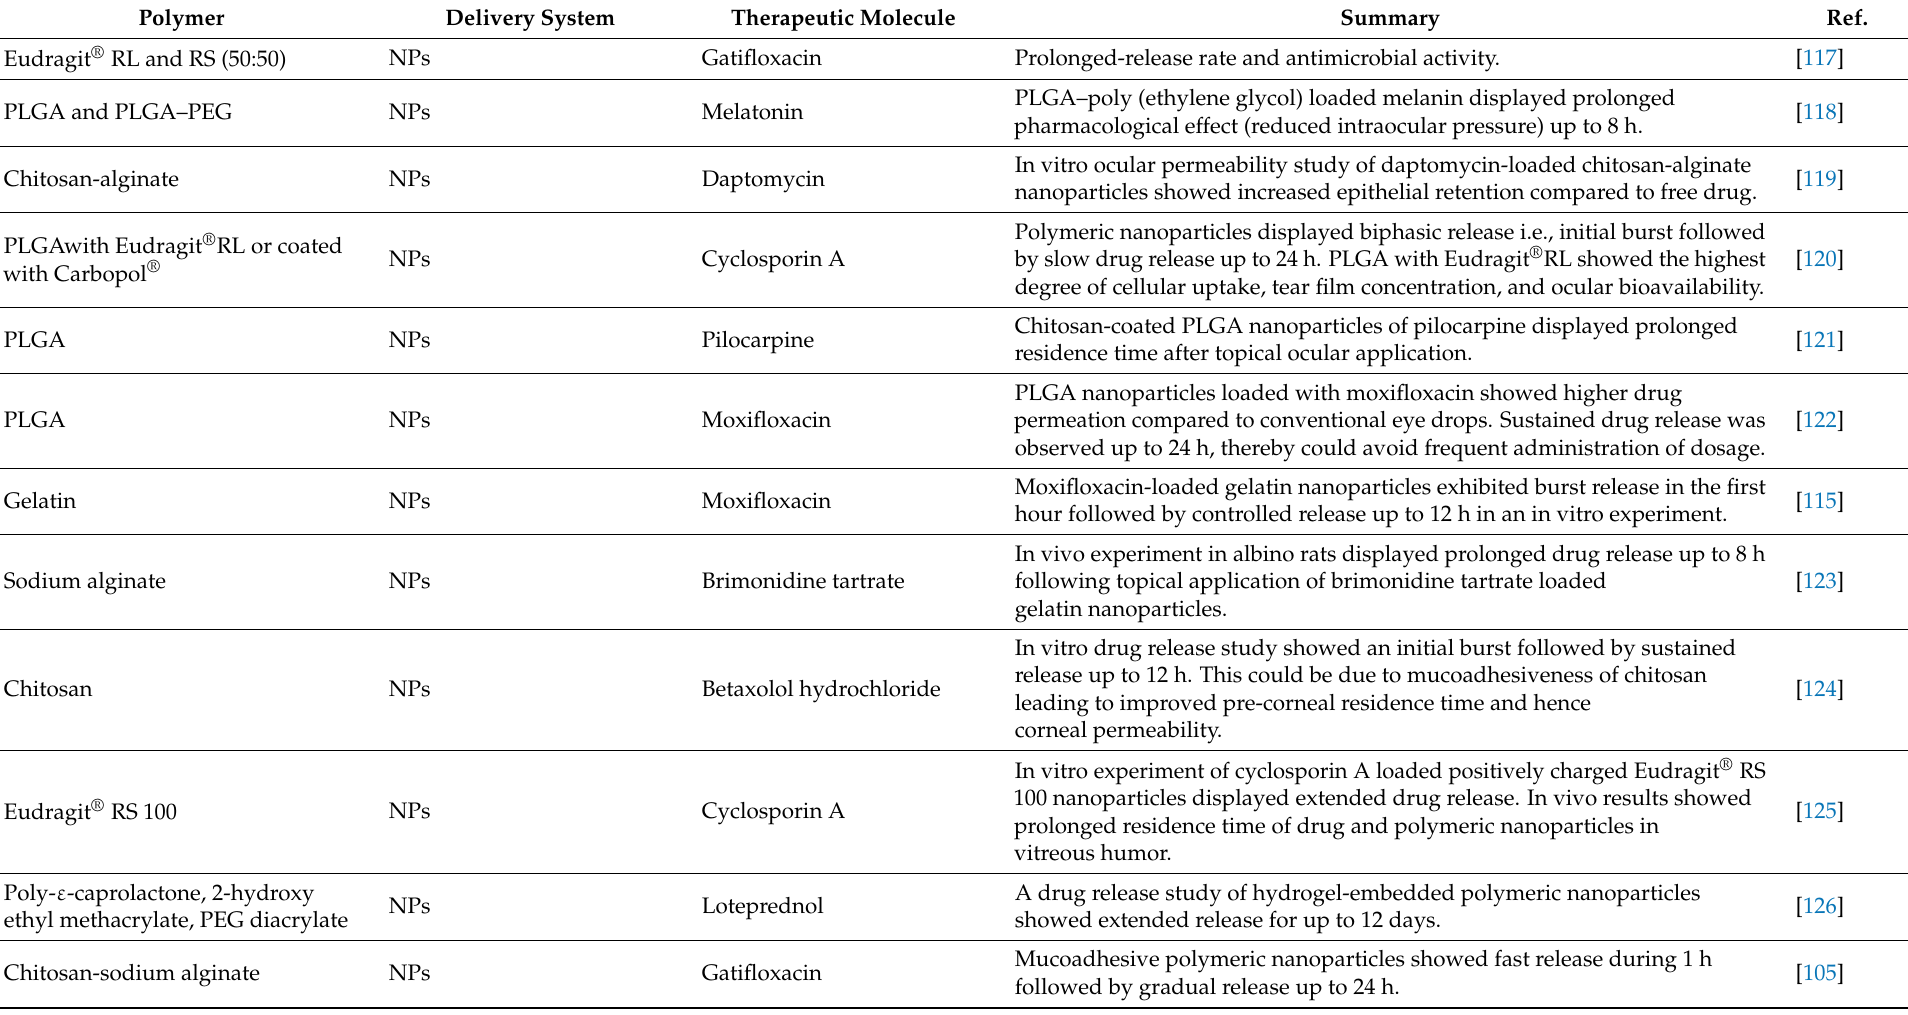
Table 3. A cross-section report on polymers employed as nanocarriers for ocular drug